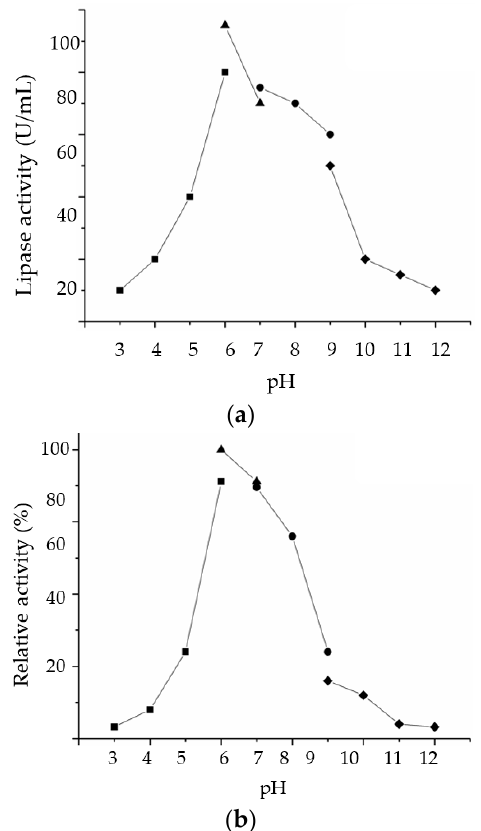
Figure 7. ( a ) Effect of pH on purified LSK25 lipase activity. Effect of pH on purified LSK25 lipase stability